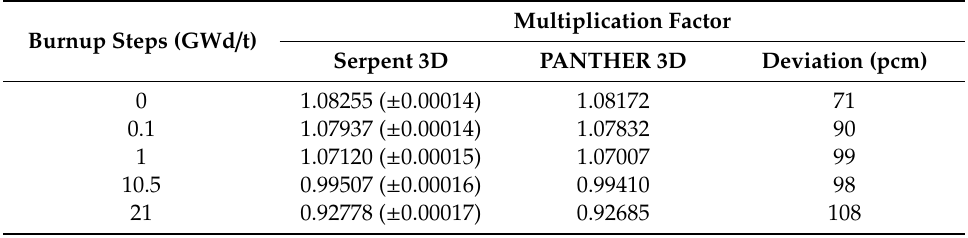
Table 3. Serpent vs. PANTHER results benchmark for the EPR 3D assembly (2.1 wt%, RCCA